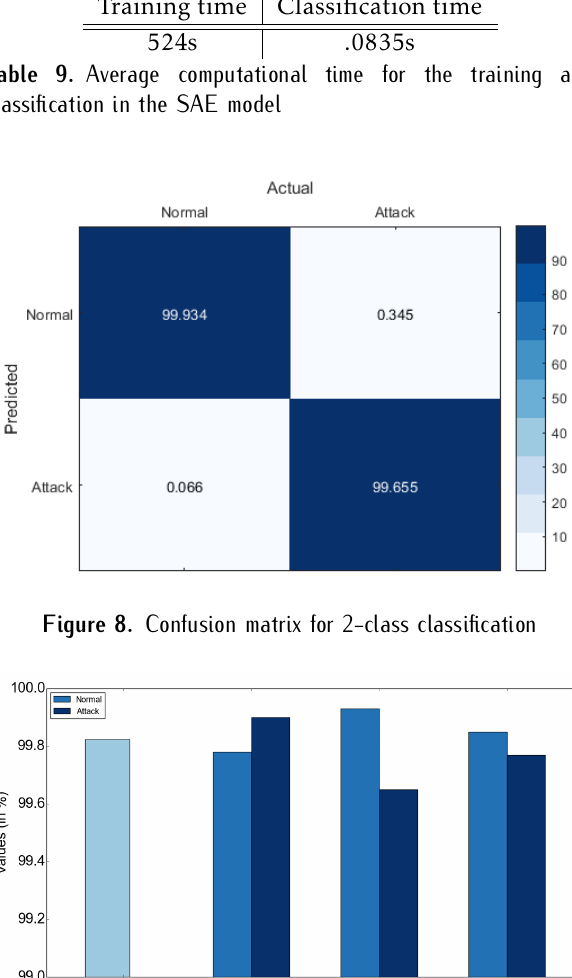
Figure 9. Accuracy, precision, recall, and f-measure for 2-class